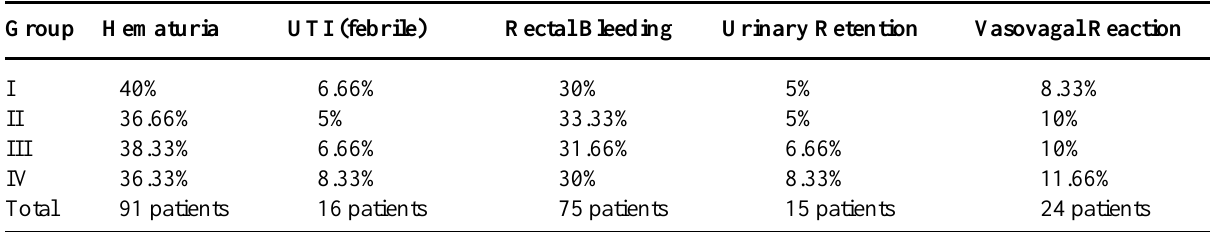
Table 4 – Comparison in the incidence of different types of biopsy- related complications among the 4 groups